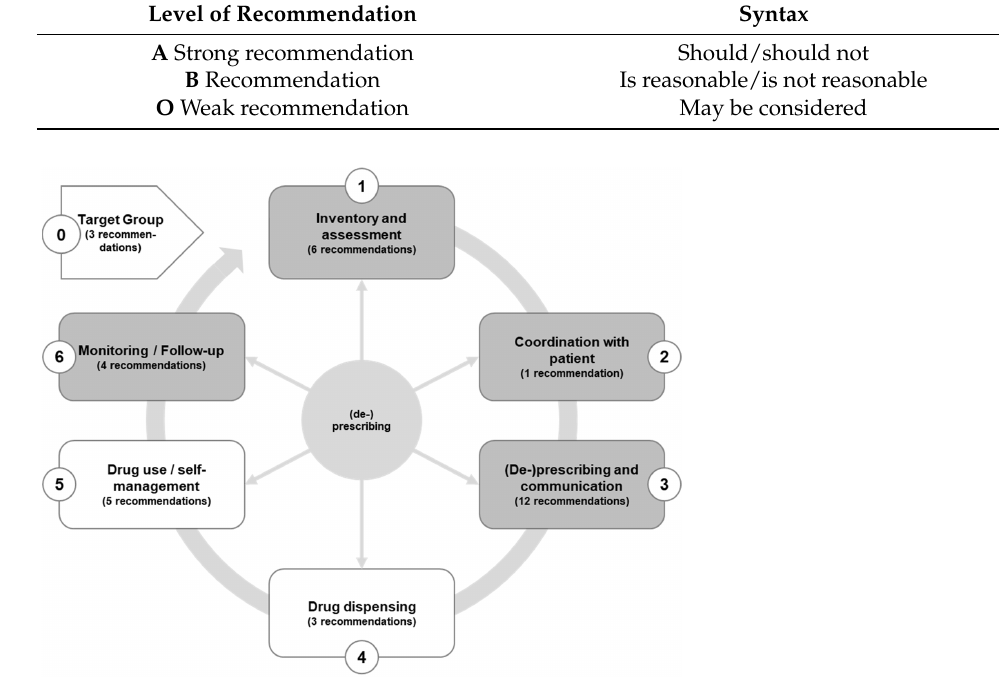
Table 3. Levels of recommendation.